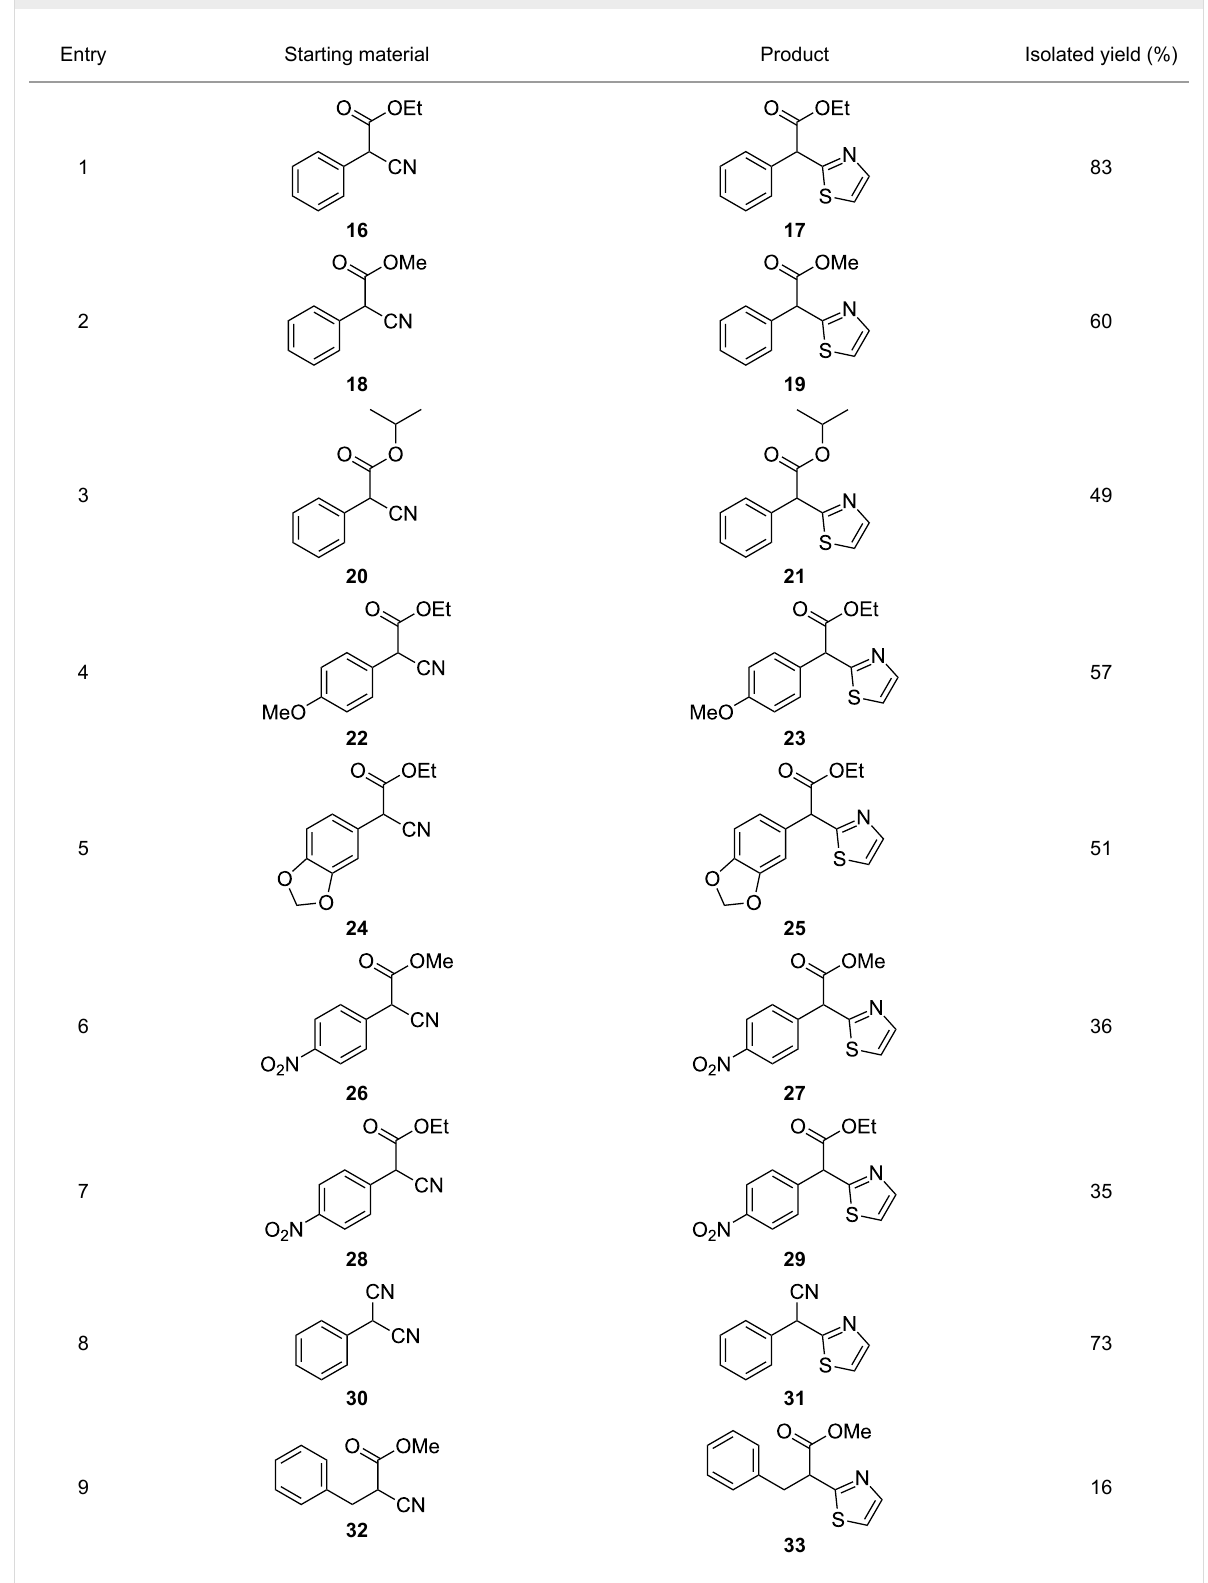
Table 4: Scoping of the 2-substituted thiazole formation.